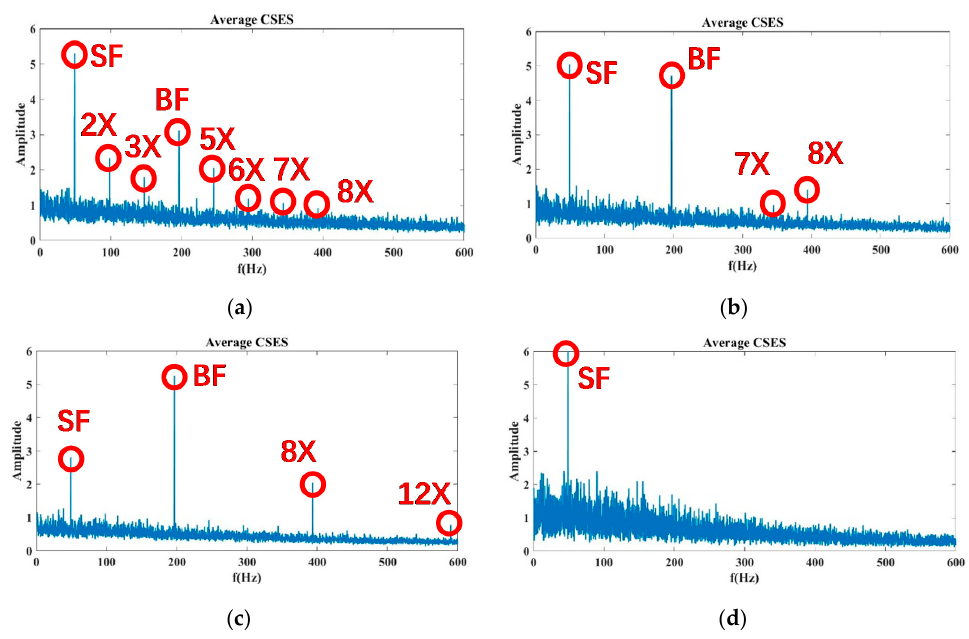
Figure 12. Average CSES spectrum of the Autogram at an 80% flow rate for Sensor 15: ( a ) Status 1: No cavitation; ( b ) Status 8: Incipient cavitation; ( c ) Status 9: Incipient cavitation; ( d ) Status 10: Severe cavitation.